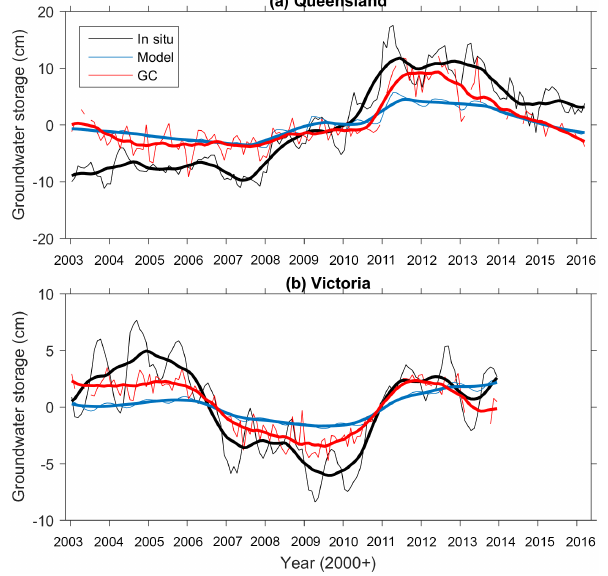
Figure 9. The monthly time series of (cid:49) GWS estimated from the model, GC solutions, and measured from the in situ groundwater network in Queensland (a) and Victoria (b) . Deseasonalized time series are shown in thick